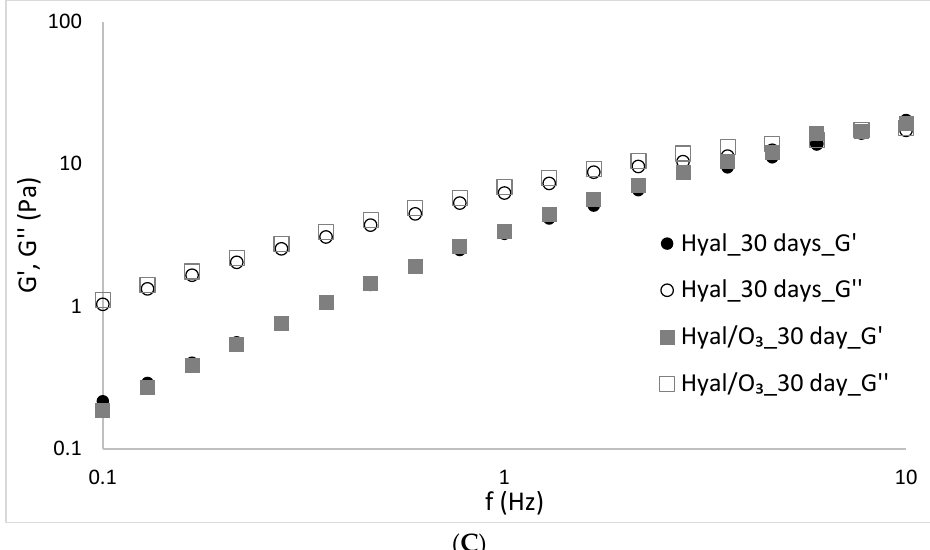
Figure 5. Values of the storage and loss moduli (G’ and G ″ ) in the stress sweep test of the Hyal/O ₃ sample measured at (A) 1, (B) 15 and (C) 30 days of storage